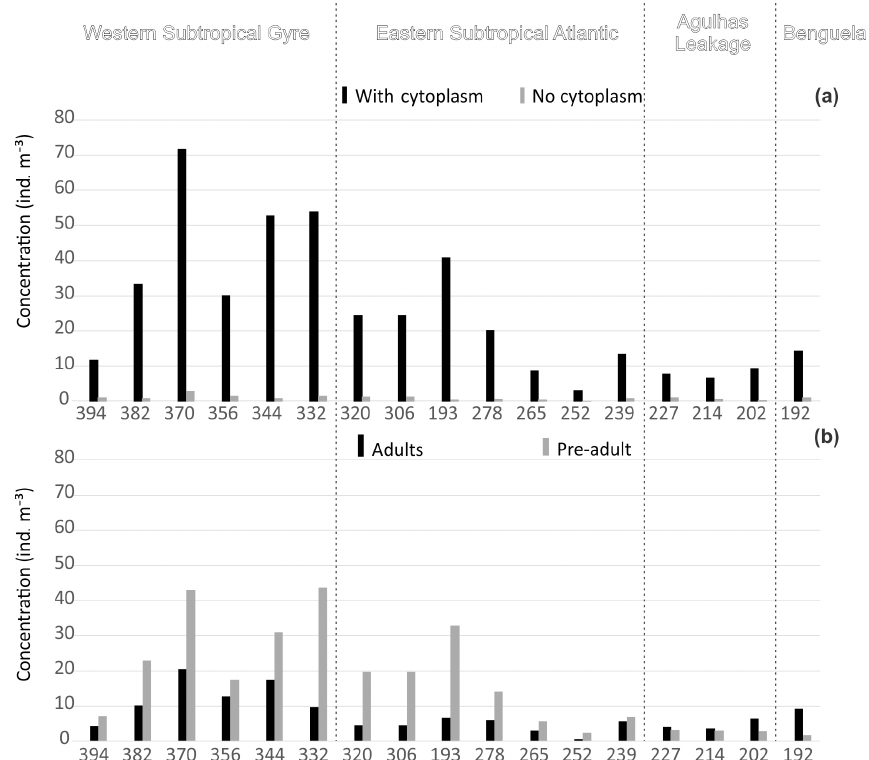
Figure 3. Concentration of planktonic foraminifera in the upper 100m. (a) Total concentration separated by presence of cytoplasm (living and dead). (b) Total standing stock separated by ontogenetic stage. Refer to the Supplement (Figs. S2 and S3) for the entire